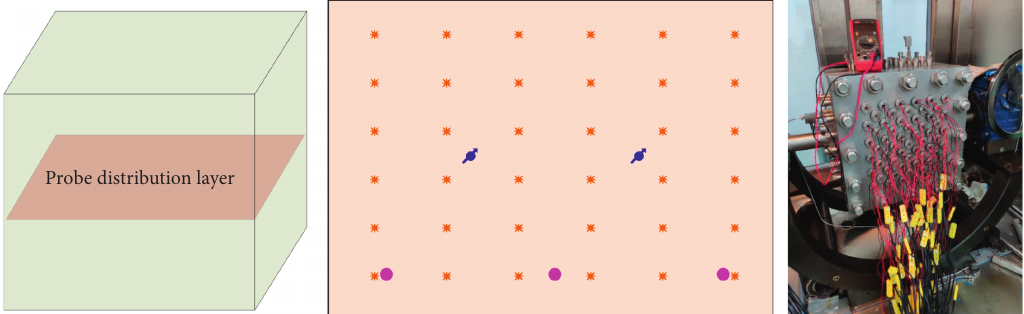
Figure 3: Electrode distribution of the 3D physical simulation experiment.